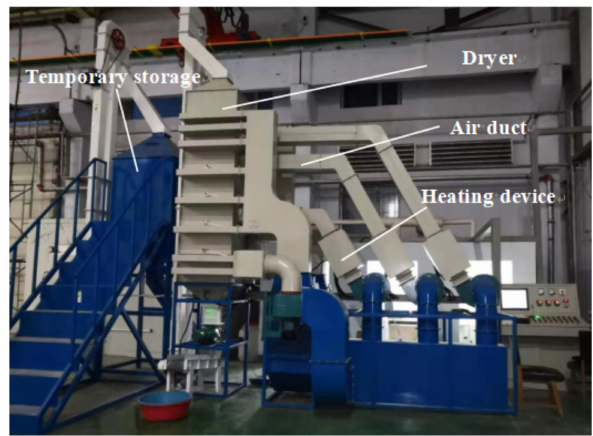
Figure 6. Drying test